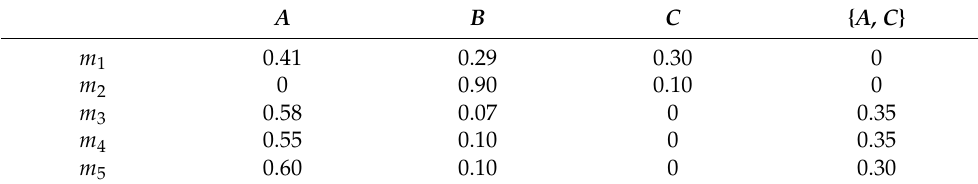
Table 9. The BPA of multi-sensor